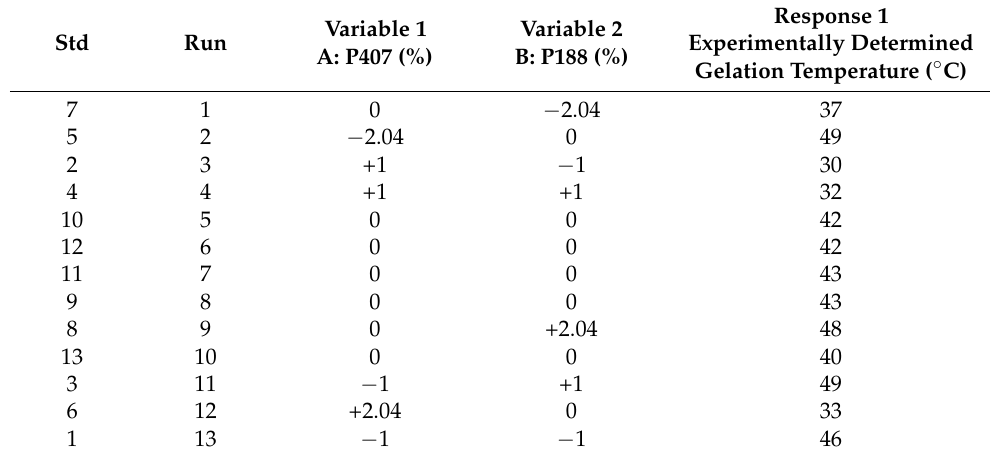
Table 4. Optimization design showing variables (in coded values) and responses.